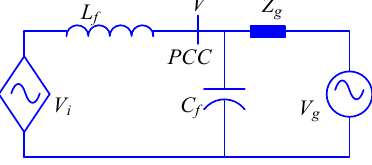
Figure 3. Simplified model of grid-connected inverter.